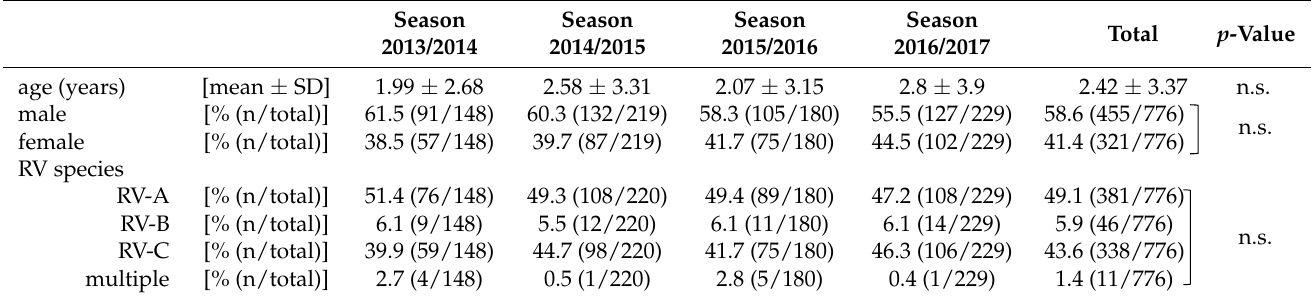
Analyzed categories are displayed in the column to the left and either given as relative and abso- lute frequencies [% (n/total)] or ranges [median ± SD]. (n/total) indicates the respective cases among the total amount of cases for the respective season. n.s., not significant. The Kruskal–Wallis